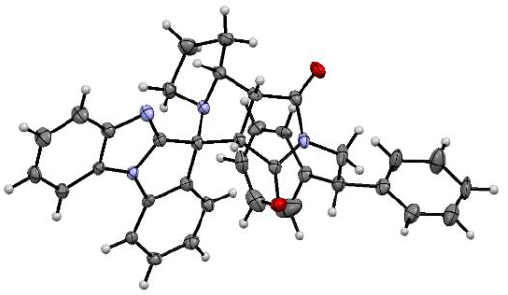
Figure 3. ORTEP representation of the molecular structure of 8f (CCDC 2195043).